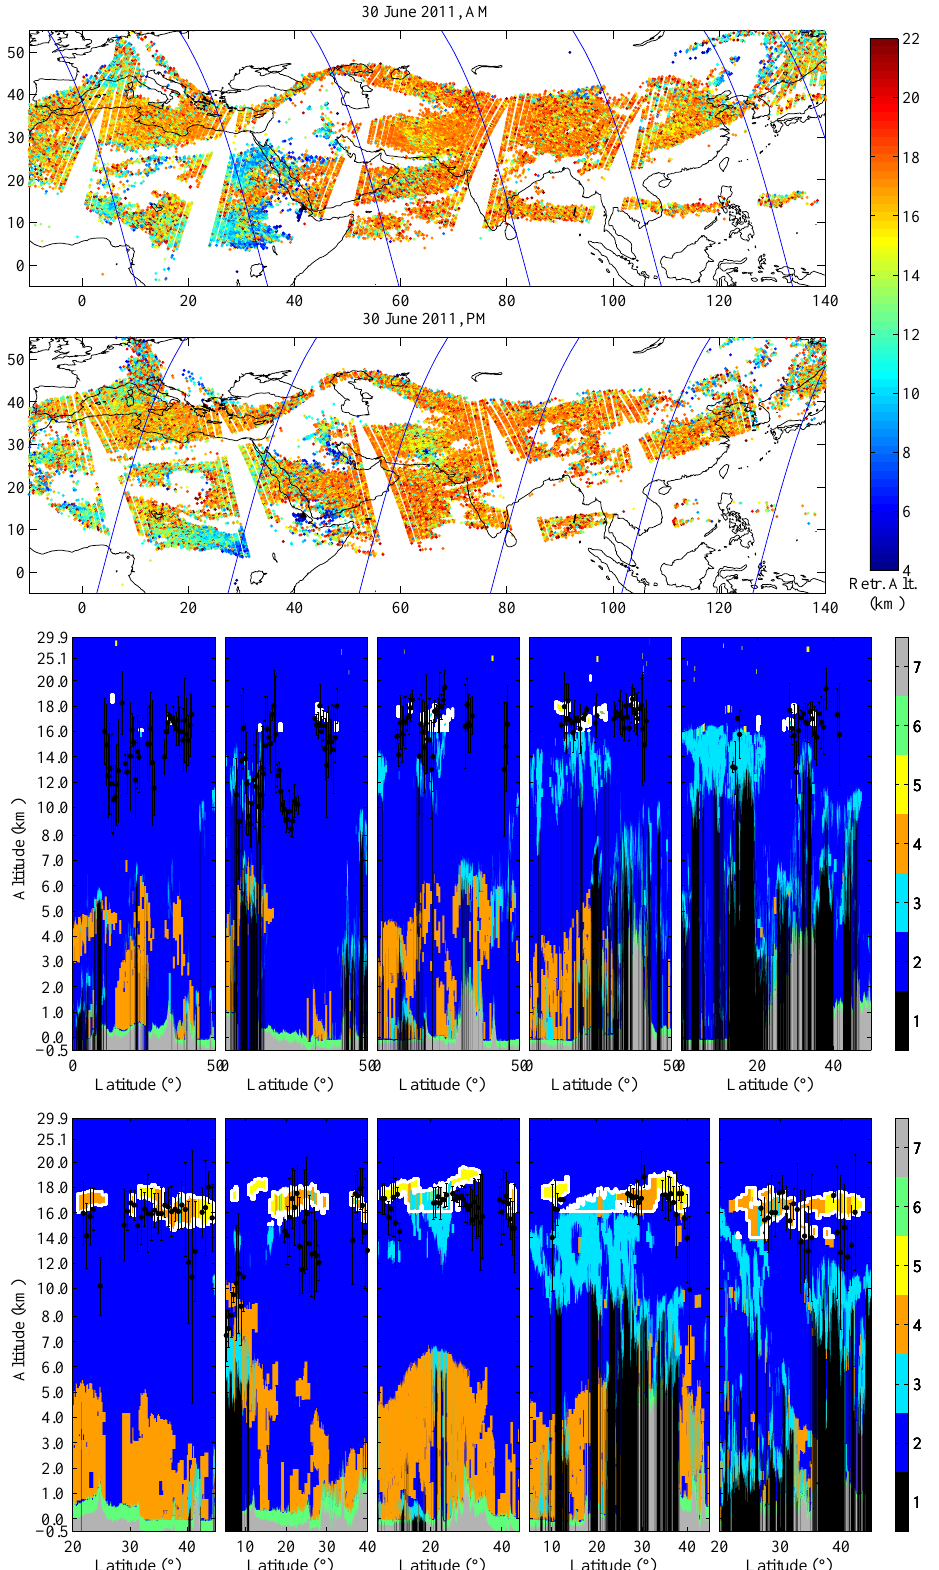
Fig. 12. Same as Fig. 6 for 30 June